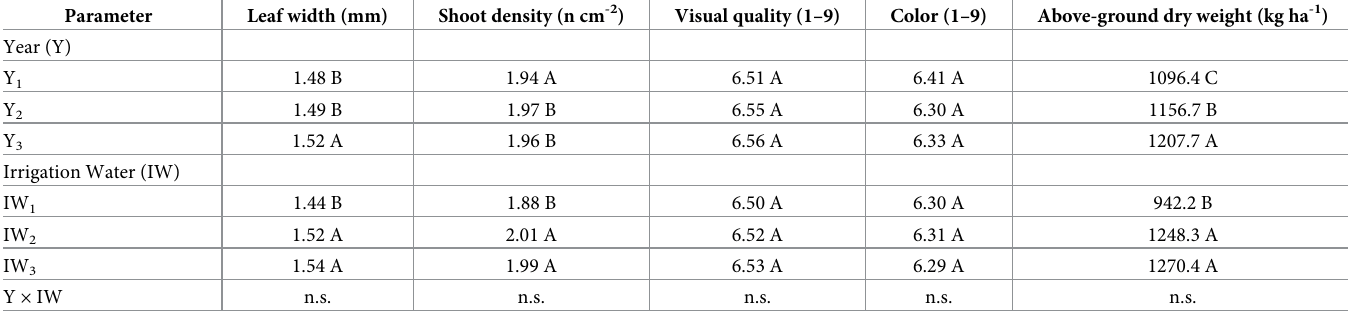
Table 8. Morphological, qualitative and production characteristics of bermudagrass plants in response to year and irrigation water during the study period. Aver- age values of 3-year tests are shown.